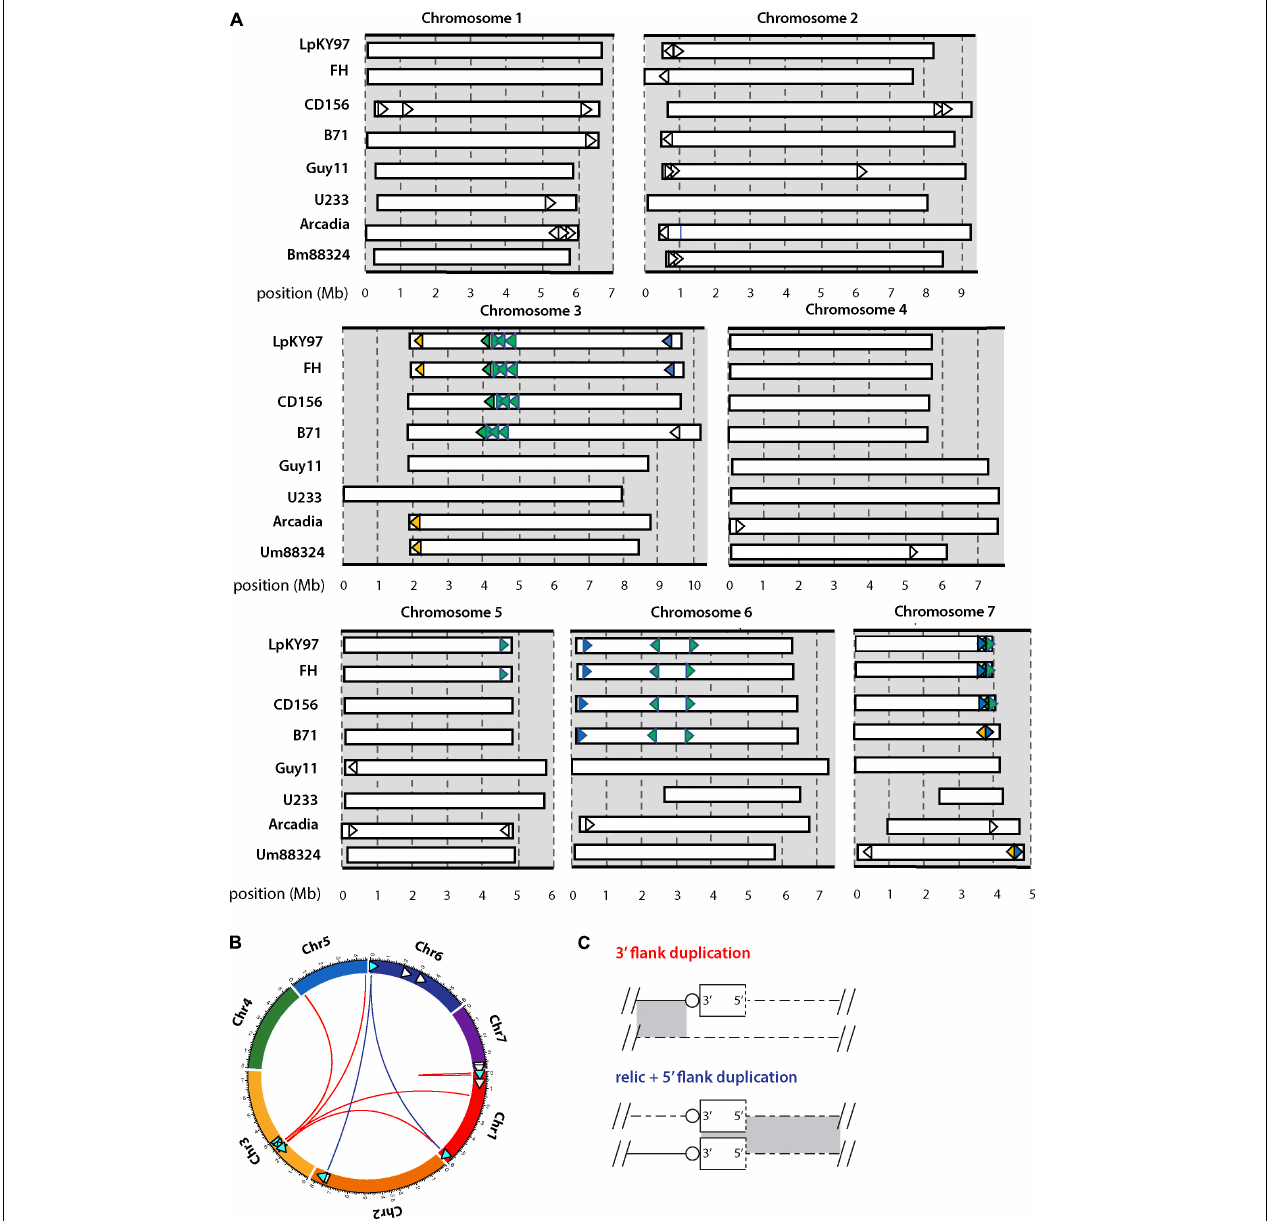
FIGURE 3 | Chromosomal distributions of MoTeR relics and associated duplications. (A) Chromosomal locations of MoTeR relics. Note: telomeric MoTeRs are not shown. Shared insertions are shown in the same color. Relics with no fill color are unique to the genome in which they are shown. (B) Circos plot showing the secondary positions of sequence duplications flanking MoTeR relics. Relics are shown with arrowheads pointing 5 (cid:48) to 3 (cid:48) . Those with associated duplication have a blue fill color. Colored lines connect the relic to the location of the duplicated sequence(s), with line color denotes the type of duplication, as shown in panel (C) . (C) Duplications surrounding a MoTeR2 relic locus are classified according to whether a duplication extends into the MoTeR 5 (cid:48) or 3 (cid:48) flank, or both. Shown are alignments between a MoTeR relic locus top and a secondary locus elsewhere in the genome. Relics are shown as rectangles with the dotted line at the 5 (cid:48) terminus representing the truncated MoTeR border. Telomere repeats at MoTeR 3 (cid:48) termini are shown as circles. Matching sequences are connected by gray